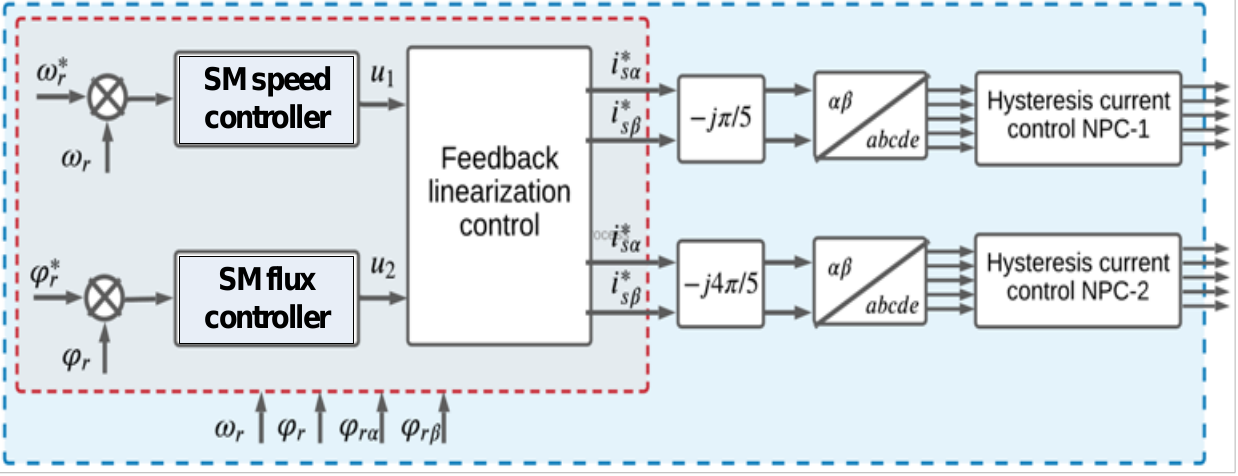
Figure 2. Simplified schematic for the proposed control of OeW-5PIM.